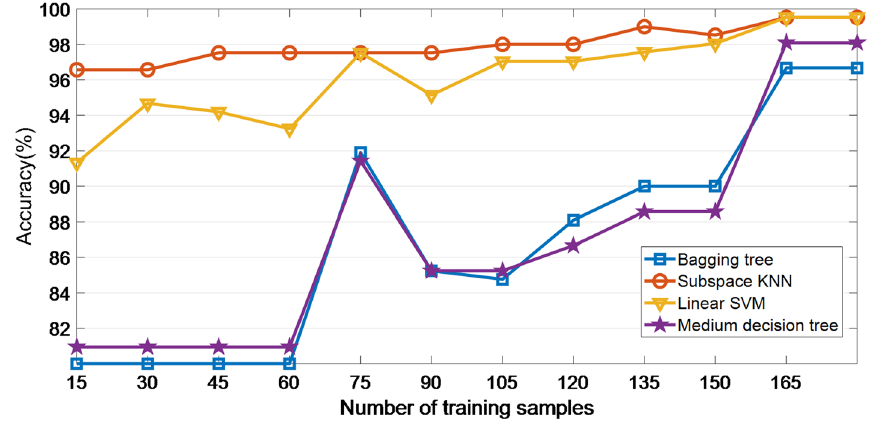
Fig. 12 Impact of the number of training samples